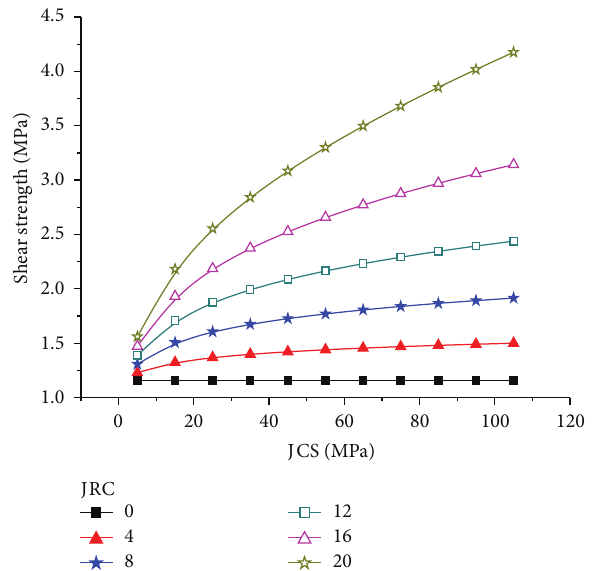
Figure 6: Relationship between the JCS and shear strength of the joint